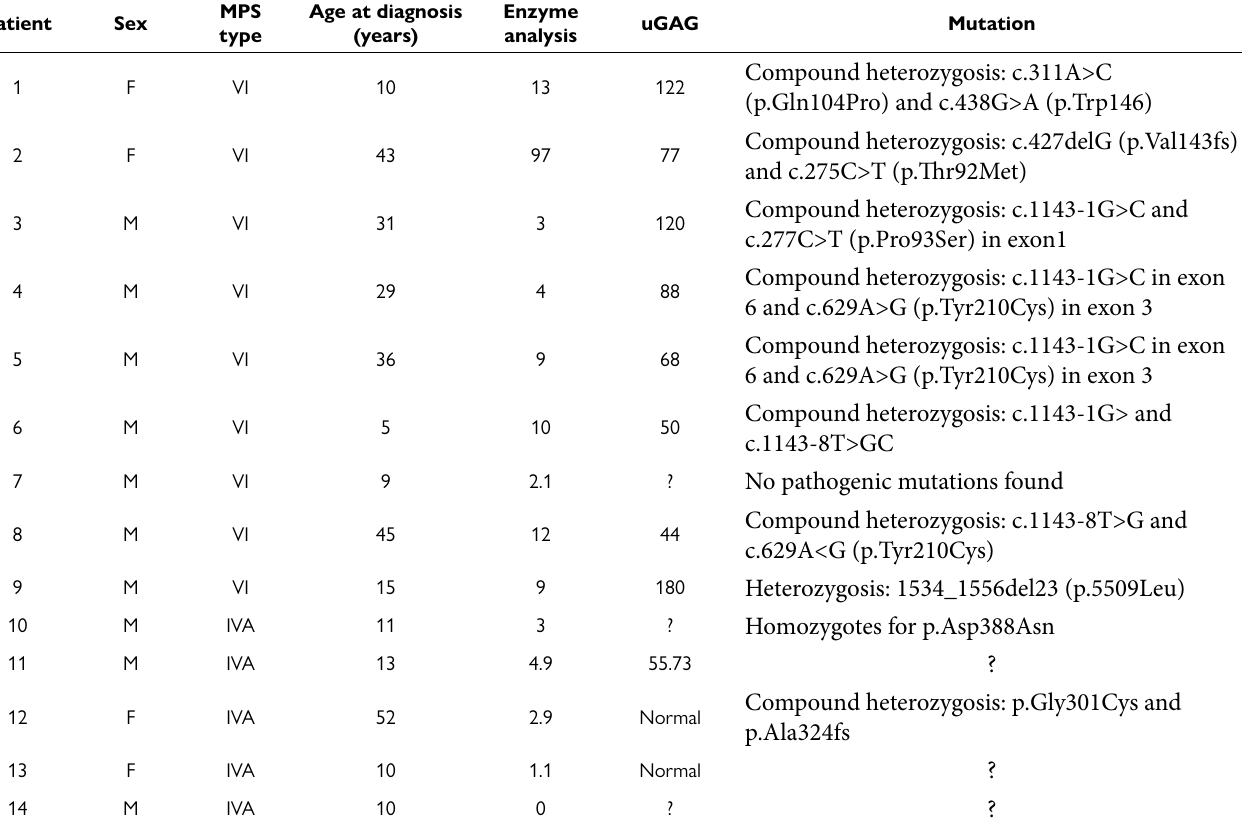
Table 1 – Patient demographics, diagnosis and biochemical and mutation analysis